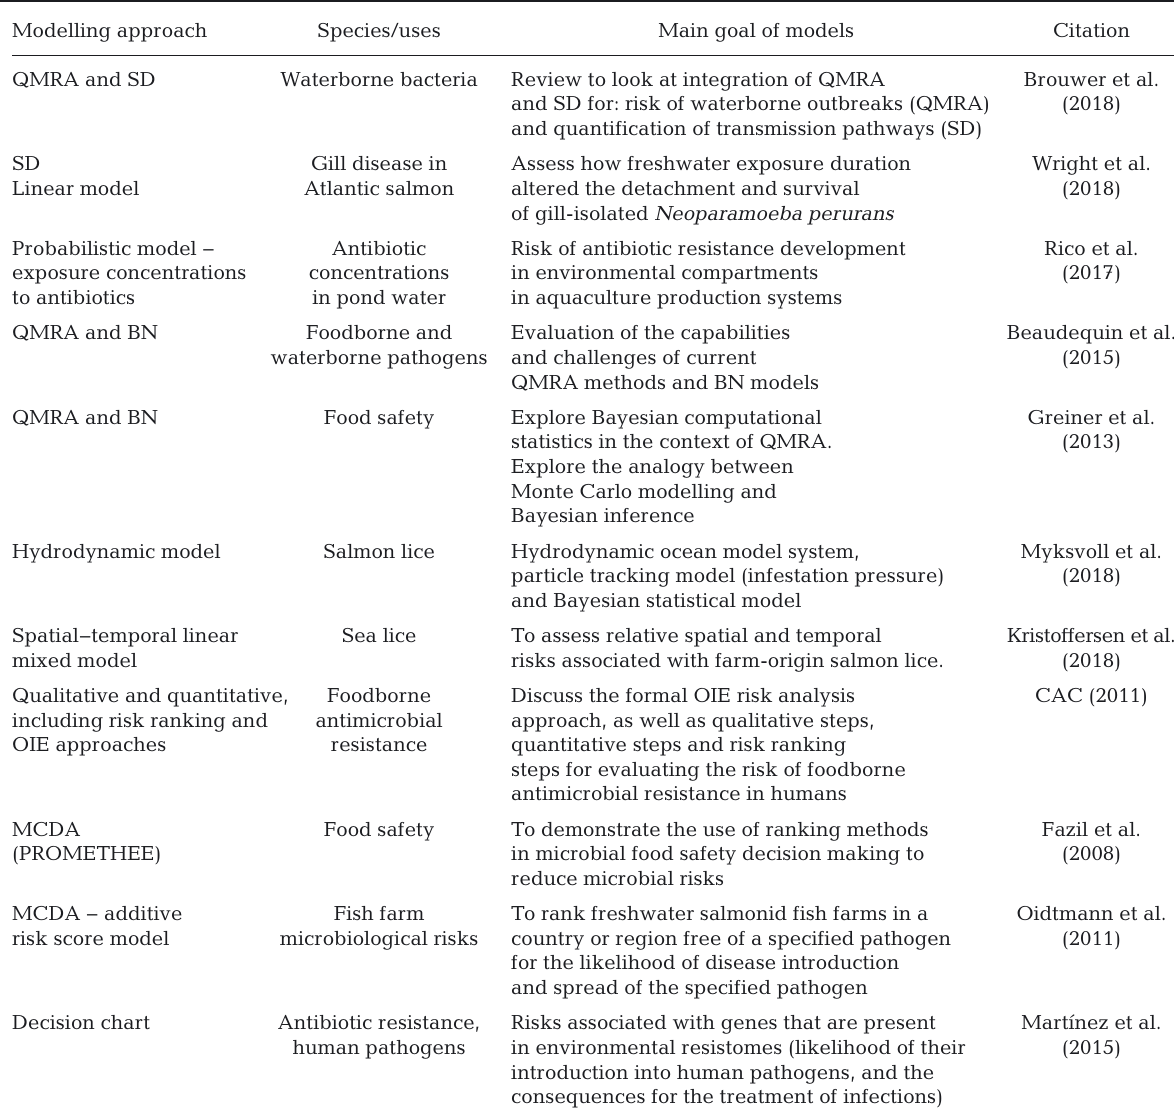
Table 4. Various modelling approaches discussed that can be incorporated or modified for a full risk analysis framework, in- cluding risk ranking, for evaluation of the risk of freshwater tolerance evolution occurring in sea lice. QMRA: quantitative